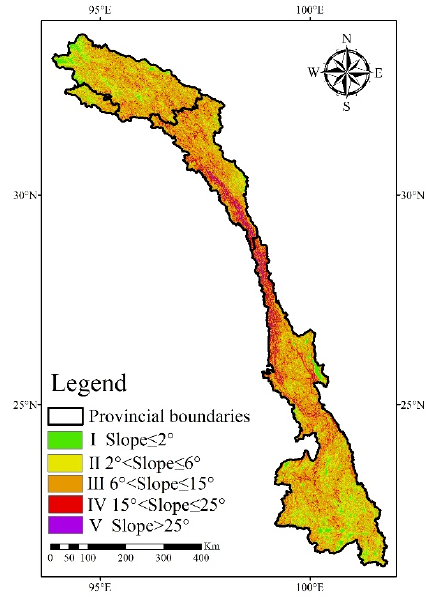
Figure 5. Land slope in the Lancang River Basin. Table 2. Changes of NDVI in the Lancang River Basin.